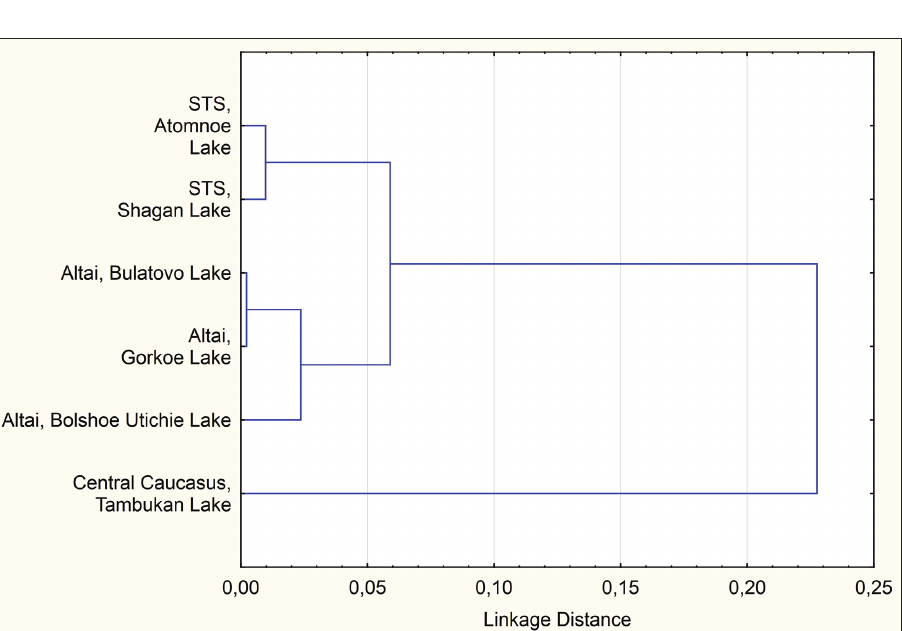
Figure 8. Tree dendrogram for six populations of G. salinus, single linkage, Euclidean